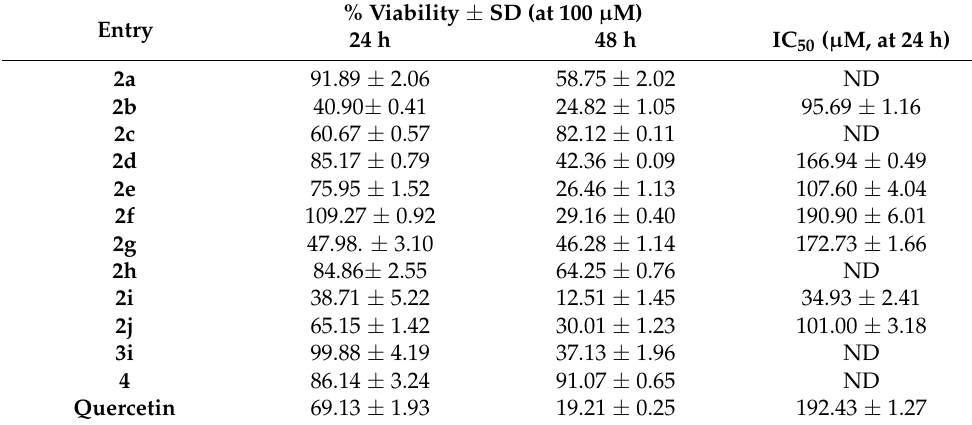
Table 3. The anticancer activity of synthesized compounds against HeLa cell.